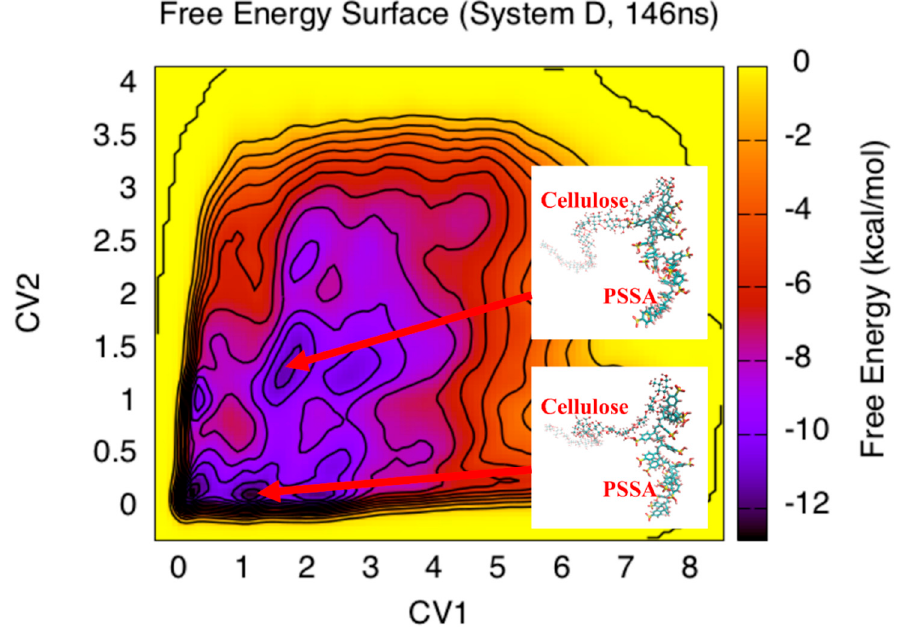
Figure 8. The 2-D free energy surface contour plot for system D involving DP 20 ionized PSSA and DP 20 cellulose chains in [EMIM]Cl. CV1 and CV2 represent the numbers of hydrogen bonds formed between them.